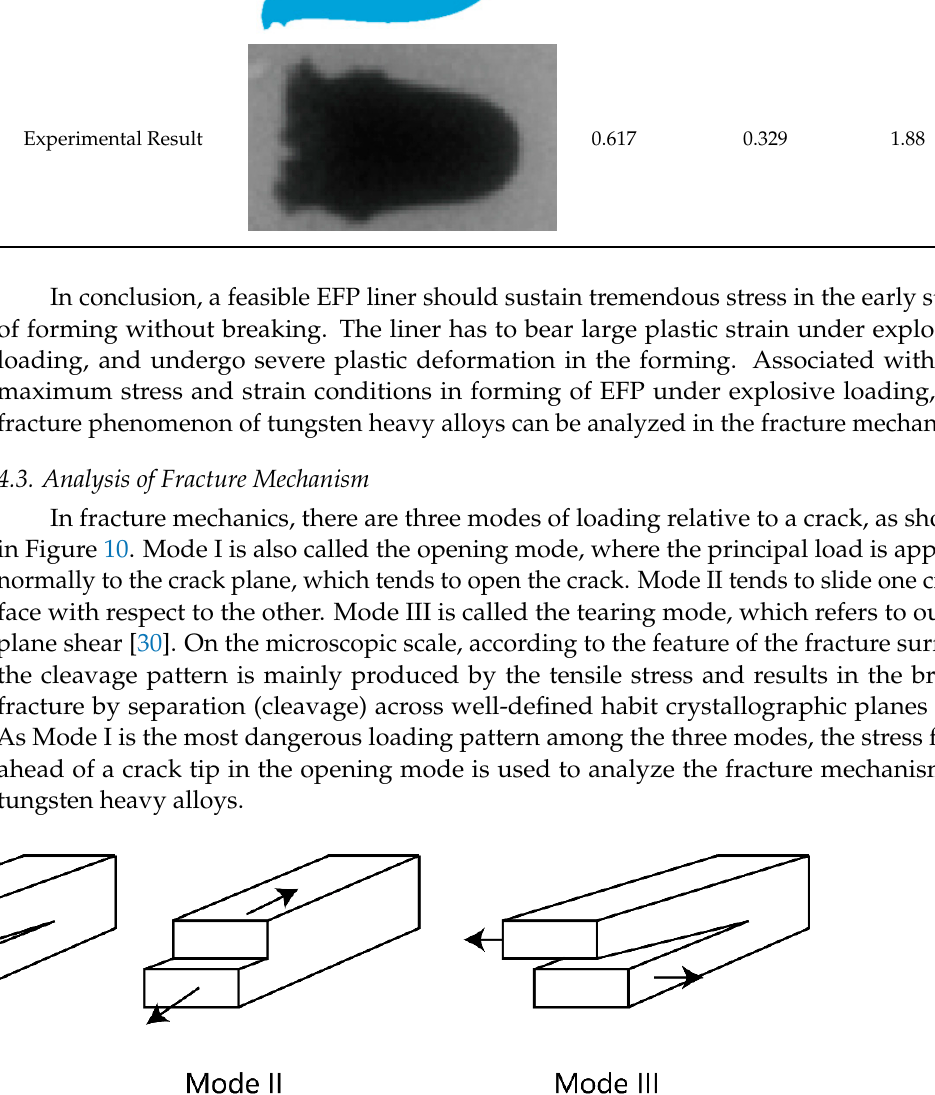
Figure 11. Definition of the coordinate axis ahead of a crack tip.